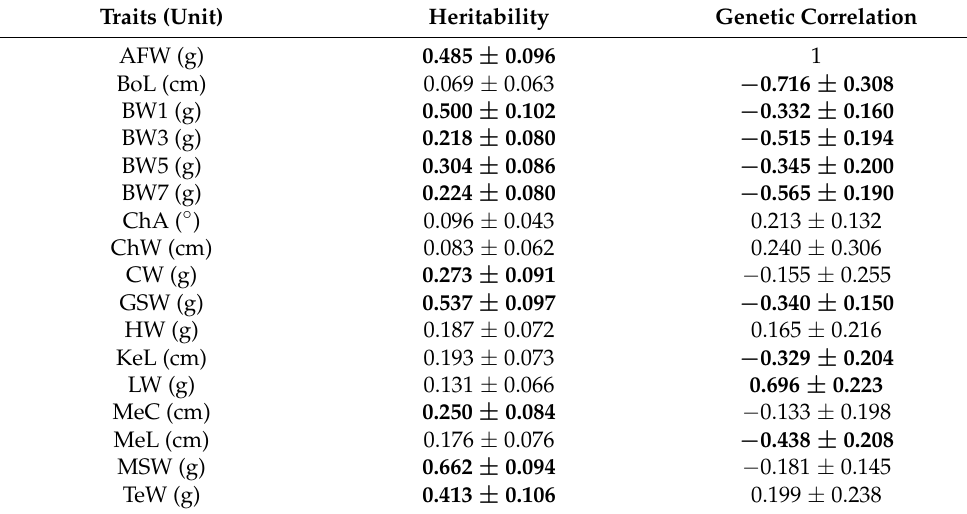
Table 3. Phenotypic traits, heritability, and genetic correlation between abdominal fat and other phenotypic traits.